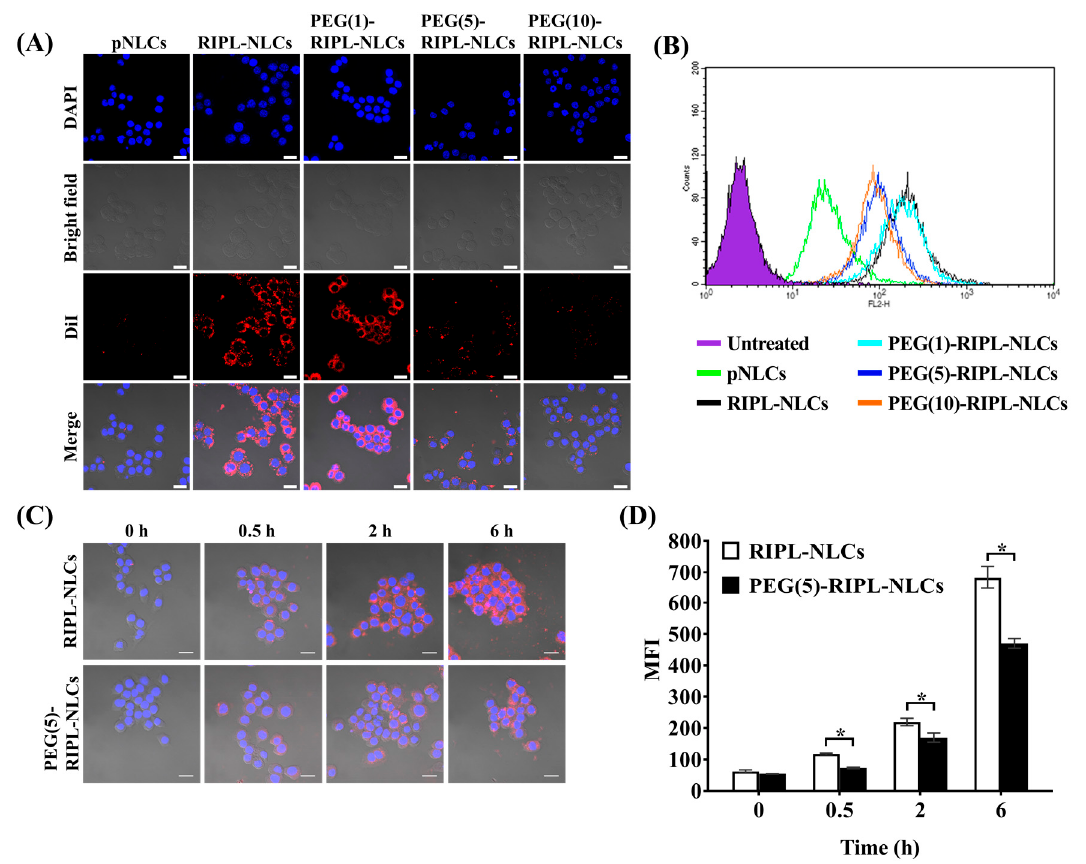
Figure 4. Phagocytic uptake of various 1,1 ′ -dioctadecyl-3,3,3 ′ ,3 ′ -tetramethylindocarbocyanine perchlorate (DiI)-loaded NLCs by RAW 264.7 macrophage cells. ( A ) Confocal laser scanning microscopy (CLSM) images after 2 h incubation. The nucleus is stained with 4 ′ ,6-diamidino-2-phenylindole (DAPI) (blue), and DiI is distributed in the cells (red). Scale bar = 20 µm. ( B ) Flow cytometry histogram of phagocytosed DiI-loaded NLCs after 2 h incubation. ( C ) CLSM images acquired after treatment with RIPL-NLCs and PEG(5)-RIPL-NLCs for different times. Scale bar = 20 µm. ( D ) MFI values calculated after treatment with RIPL-NLCs and PEG (5 mole %)-grafted RIPL-NLCs (PEG(5)-RIPL-NLCs). Data are the mean ± SD ( n = 3). * p < 0.05.